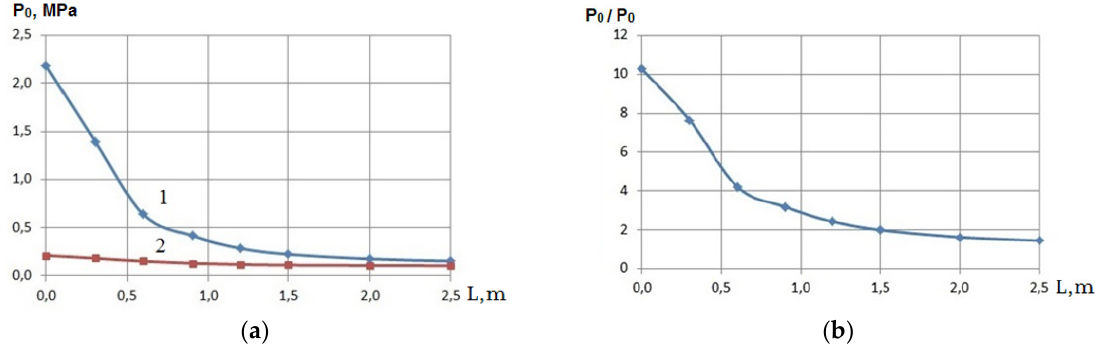
Figure 16. Distribution of the mass average values of the total pressure over the jet length in calculation: ( a ) 1—P 02 (0) = 2.35 MPa; 2—P 02 (0) = 0.235 MPa; ( b ) ratio of the total pressure (P 02 (0) = 2.35/P 02 (0) = 0.235) over the jet